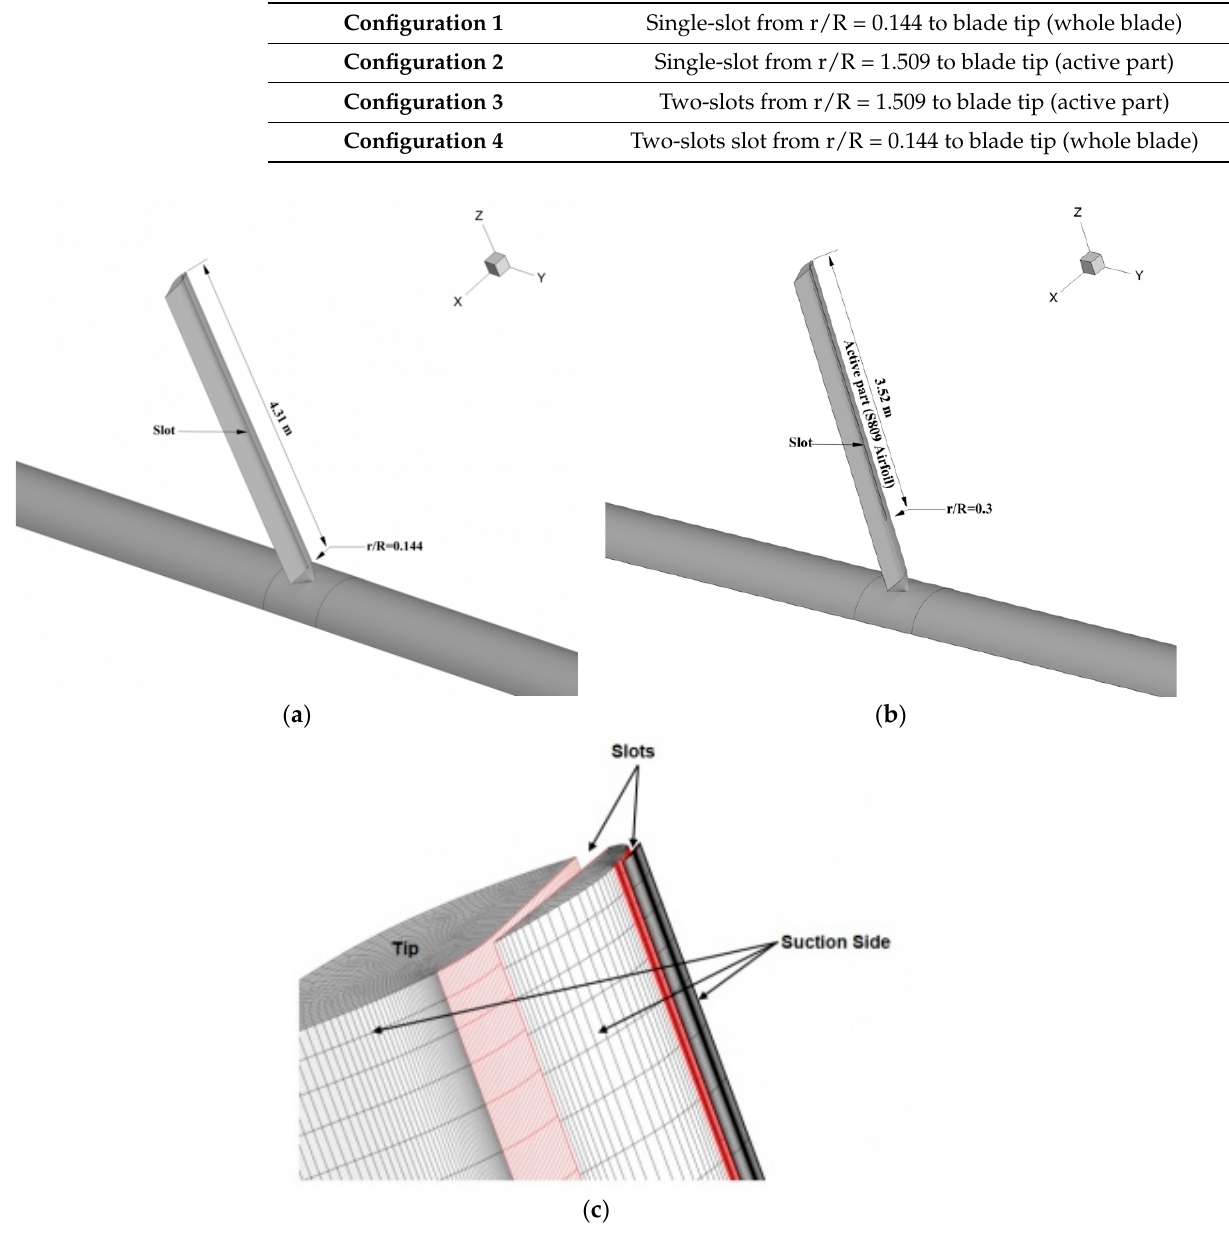
Figure 7. Geometric characteristics and mesh of the slot(s). ( a ) Configuration 1; ( b ) Configuration 2; ( c ) Configurations 3 and 4.